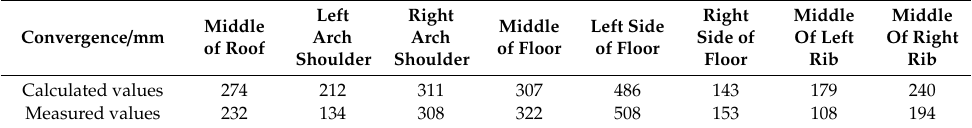
Figure 11. Displacement field evolution characters in the roadway surrounding rock during the excavation unloading process. Table 5. Measured and calculated convergence values in critical location of